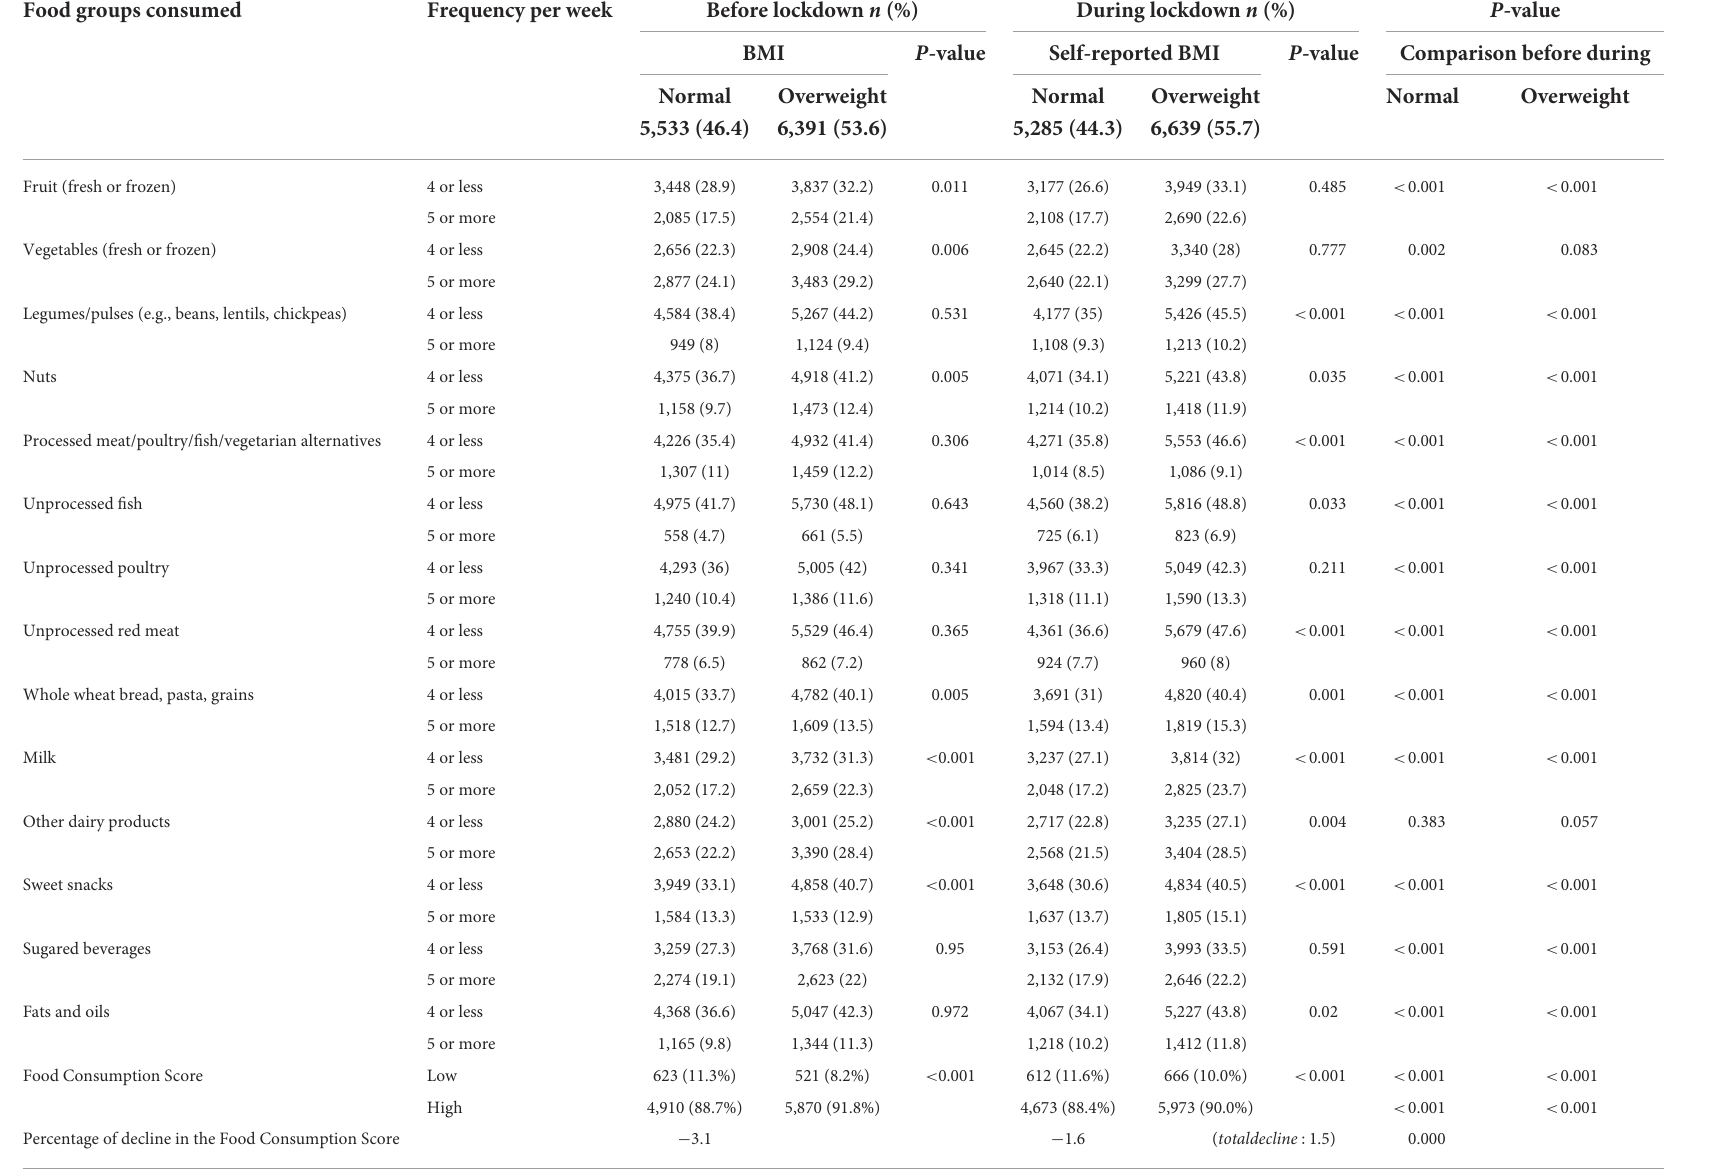
TABLE 3 Food groups consumption and food consumption scores among study participants before and during the COVID-19 pandemic based on self-reported BMI. Food groups consumed Frequency per week Before lockdown n (%) During lockdown n (%) P -value BMI P -value Self-reported BMI P -value Comparison before during Normal Overweight Normal Overweight Normal